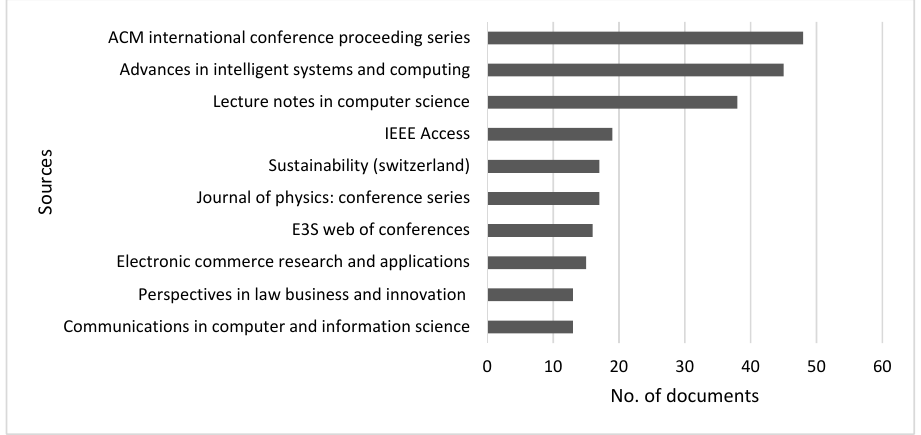
Figure 3. Most relevant sources, according to publications.